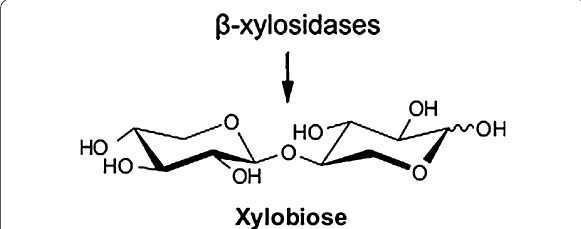
Fig. 1 Schematic representation of hemicellulose degradation by β-Xylosidases which release xylose from xylobiose (Kousar et al.